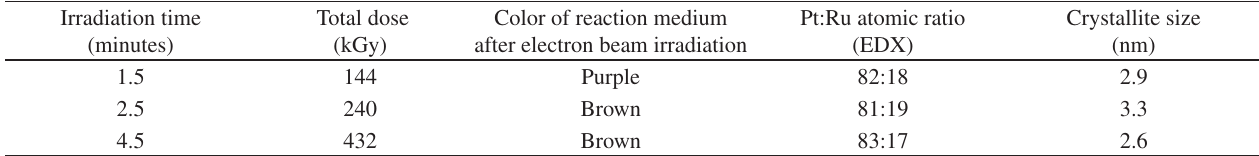
Table 1. Influence of electron beam irradiation time on Pt:Ru atomic ratio and average crystallite size of the PtRu/C electrocatalysts (20 wt. (%) of metals, nomimal Pt:Ru atomic ratio of 50:50, dose rate 1.6 kGys –1